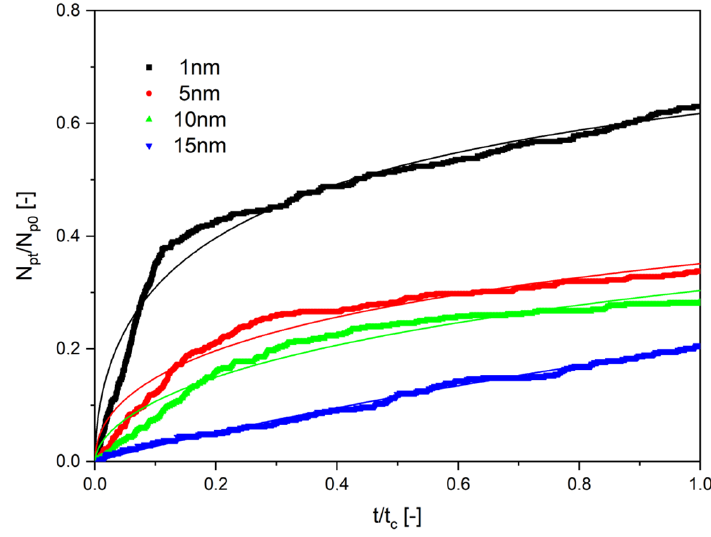
Figure 5. The dependence on the normalized number of particles as a function of normalized time. The viscosity of the liquid was 20 mPa · s for particles of different diameters.